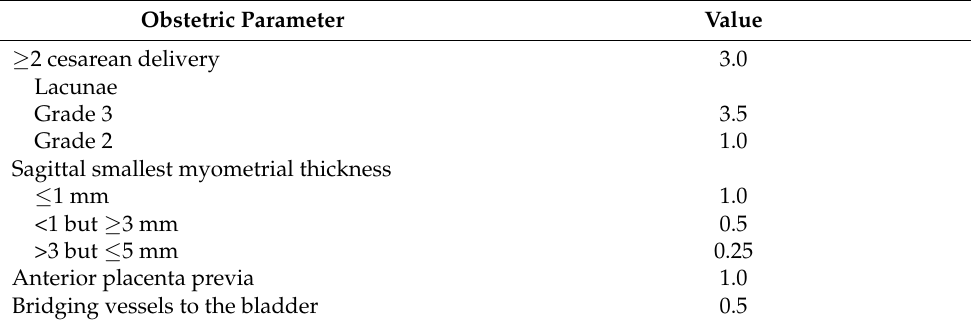
Table 1. Clinical values of obstetric parameters for evaluating the placenta accreta index. Obstetric Parameter Value